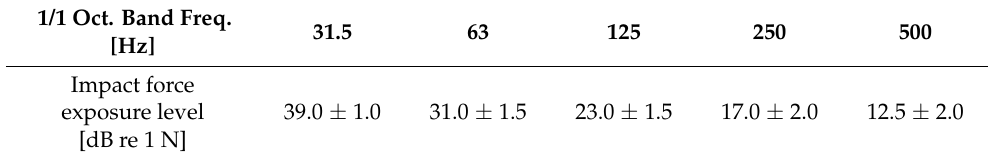
Table 2. Impact force exposure level in each octave band of the rubber ball. 1/1 Oct. Band